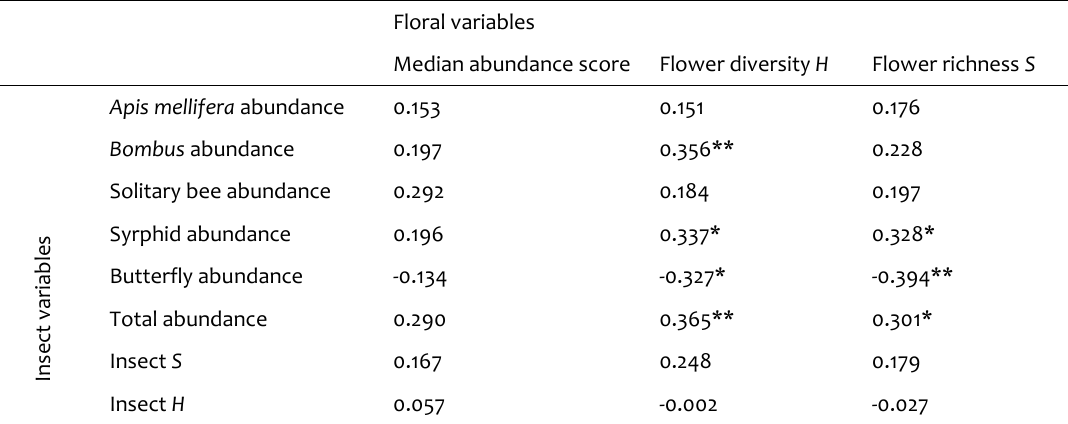
Table 3. Spearman’s rank correlation coefficients ( r S ) showing strength and direction of relationships between attributes of pollinating insect assemblage and diversity and abundance of flowering plants in field boundaries during 3 site visits. [Critical values of r S with n = 33, P < 0.05 |0.356|** and P < 0.1 |0.301|*]. Floral variables Median abundance score Flower diversity